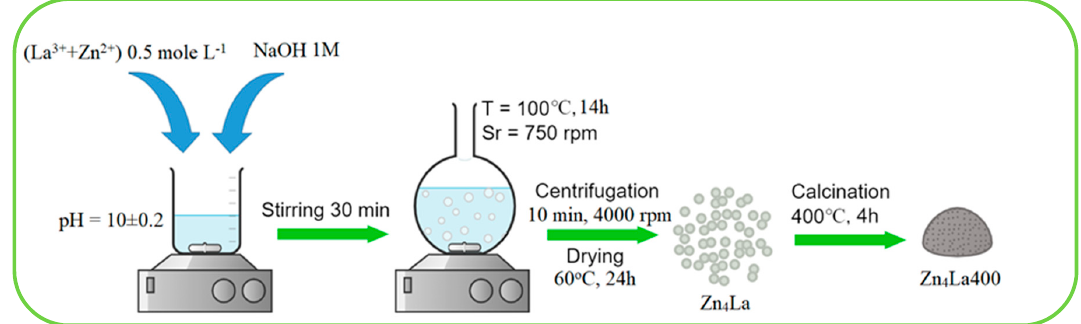
Figure 1. Schematic presentation of the main preparation steps used for synthesis of Zn 4 La mixed